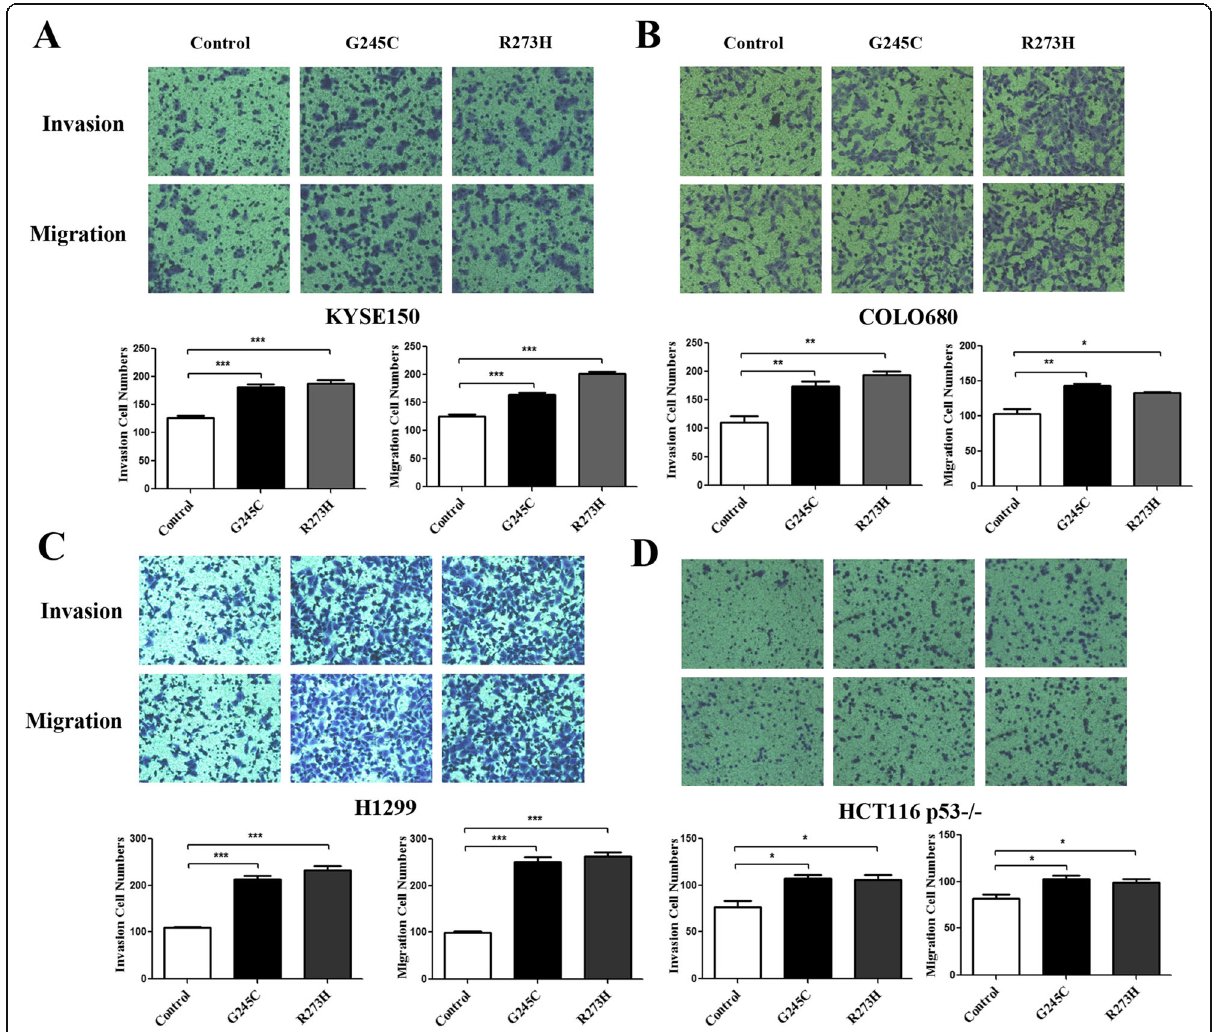
Fig. 3 TP53 G245C and R273H mutants promoted tumor cells invasion and migration. a Invasion and migration activities were examined by Matrigel ™ invasion chamber in KYSE150 cell line. b Invasion and migration activities were assessed in COLO680 cell line. c Invasion and migration abilities were verified in H1299 cell line. d Invasion and migration activities were tested in HCT116 p53 − / − cell line. Data was shown as mean ± SE. (* P < 0.05, ** P < 0.01, *** P <